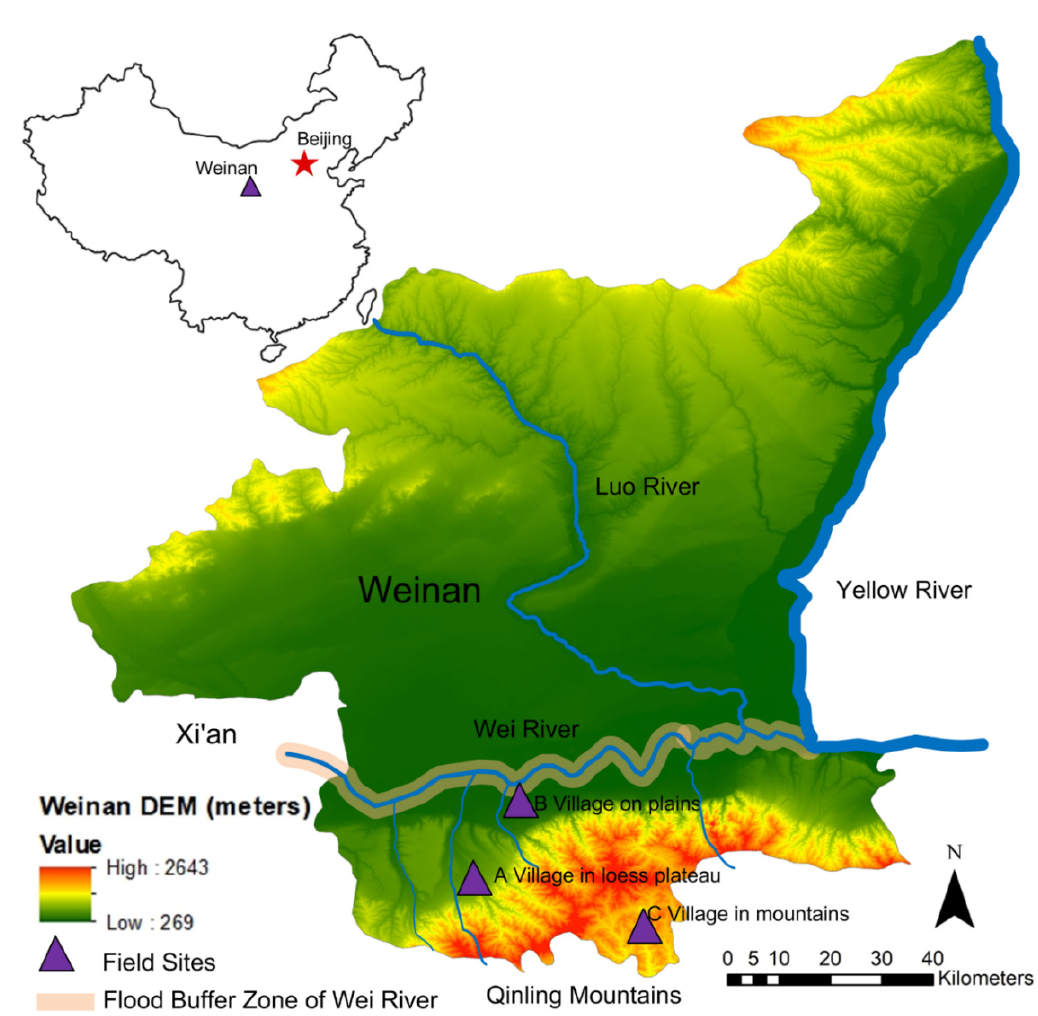
Figure 1. Map of site selection. Source: DEM data was derived from Space Shuttle Radar Topography Mission, NASA